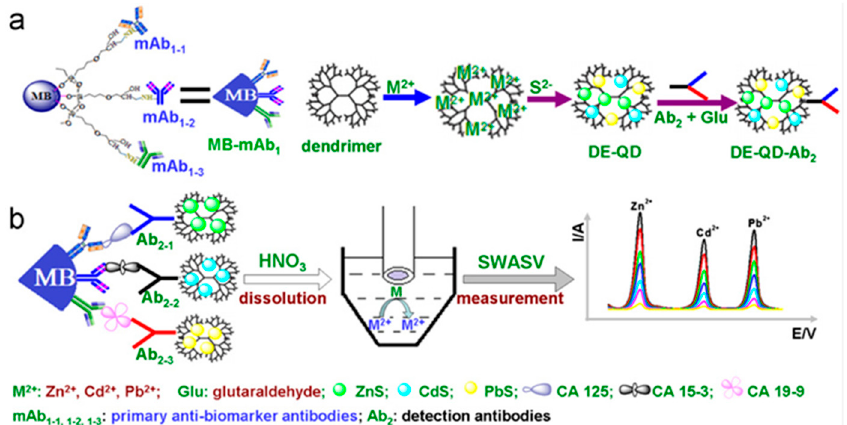
Figure 9. Multiplexed stripping voltammetric immunoassay using dendrimer-metal sulfide QD nanolabels (DE-QD) and tri-functionalized magnetic beads for the simultaneous determination of CA125, CA15-3 and CA19-9 cancer biomarkers: ( a ) preparation process and ( b ) measurement principle. Reprinted from [13] with permission.